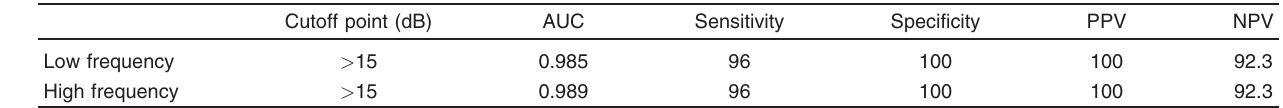
Table 3 Predictive performance of audiogram in chronic obstructive pulmonary disease